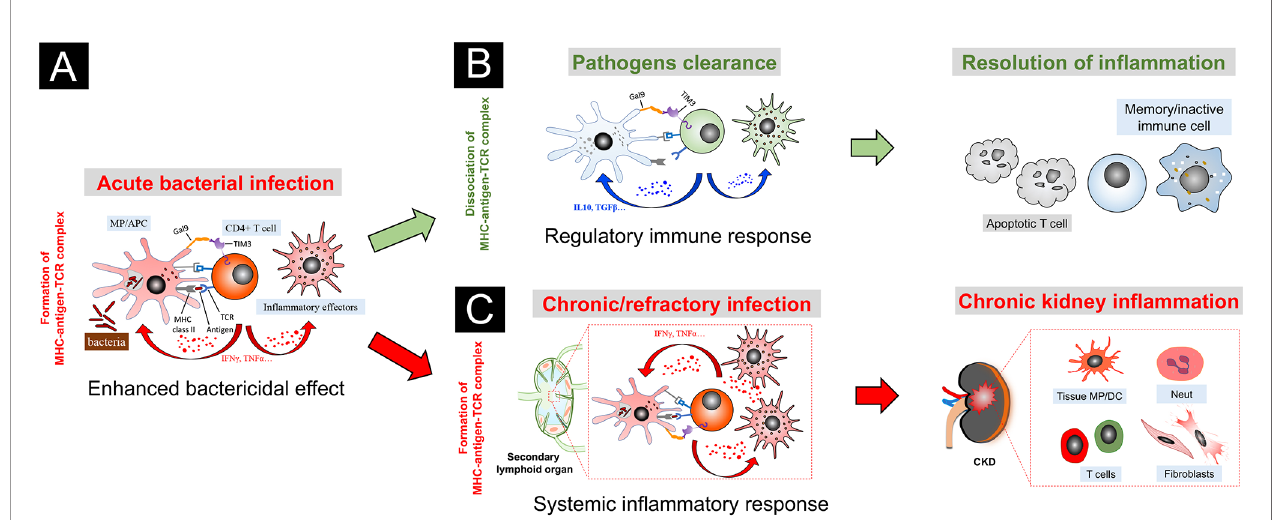
FIGURE 2 | A speculative model of TIM3-GAL9 axis in chronic kidney in fl ammation triggered by bacterial infection. (A) In acute stage of infection, bacterial antigens are presented to T cells by macrophage (MP) or antigen-presenting cell (APC). Upon activation, the primed T cells proliferate with TIM3 induction. With the synergic action of MHC II-antigen-TCR complex, TIM3-GAL9 interaction promotes the effector T cells that secrete abundant pro-in fl ammatory cytokines, like TNF a and IFN g , to enhance bactericidal capacities of the phagocytes. Likewise, these paracrine cytokines induce activation of peripheral effector cells and amplify the systemic in fl ammatory response. (B) Upon pathogens clearance, the MHC-antigen-TCR complex unravels. TIM3-GAL9 axis, in turn, exerts an inhibitory action on T cells by induction of regulatory cytokines (like IL10 and TGF b ). In this context, TIM3-GAL9 interaction facilitates the resolution of tissue in fl ammation by induction of T cells apoptosis and transition of memory immune cells. (C) In the case of chronic/refractory infection, the immune system fails to eliminate the intracellular bacteria. The synergy of the MHC-antigen-TCR complex with the TIM3-GAL9 axis persistently stimulates the activation of peripheral immune cells, which are attracted into the involved kidneys of CKD by diseased renal microenvironment and participate in progressive kidney in fl